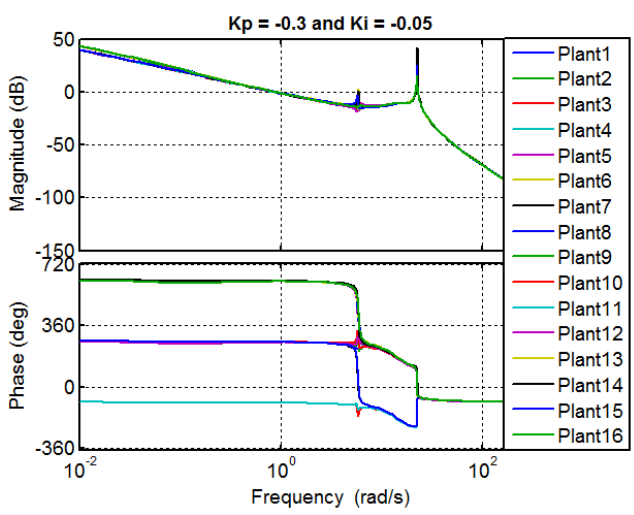
Figure 13. The frequency response plot wherein atleast 30 0 phase marin is achieved for all 16 Kharitonov plants with Kp(-0.3) and Ki(-0.7) - a point from Figure 8.